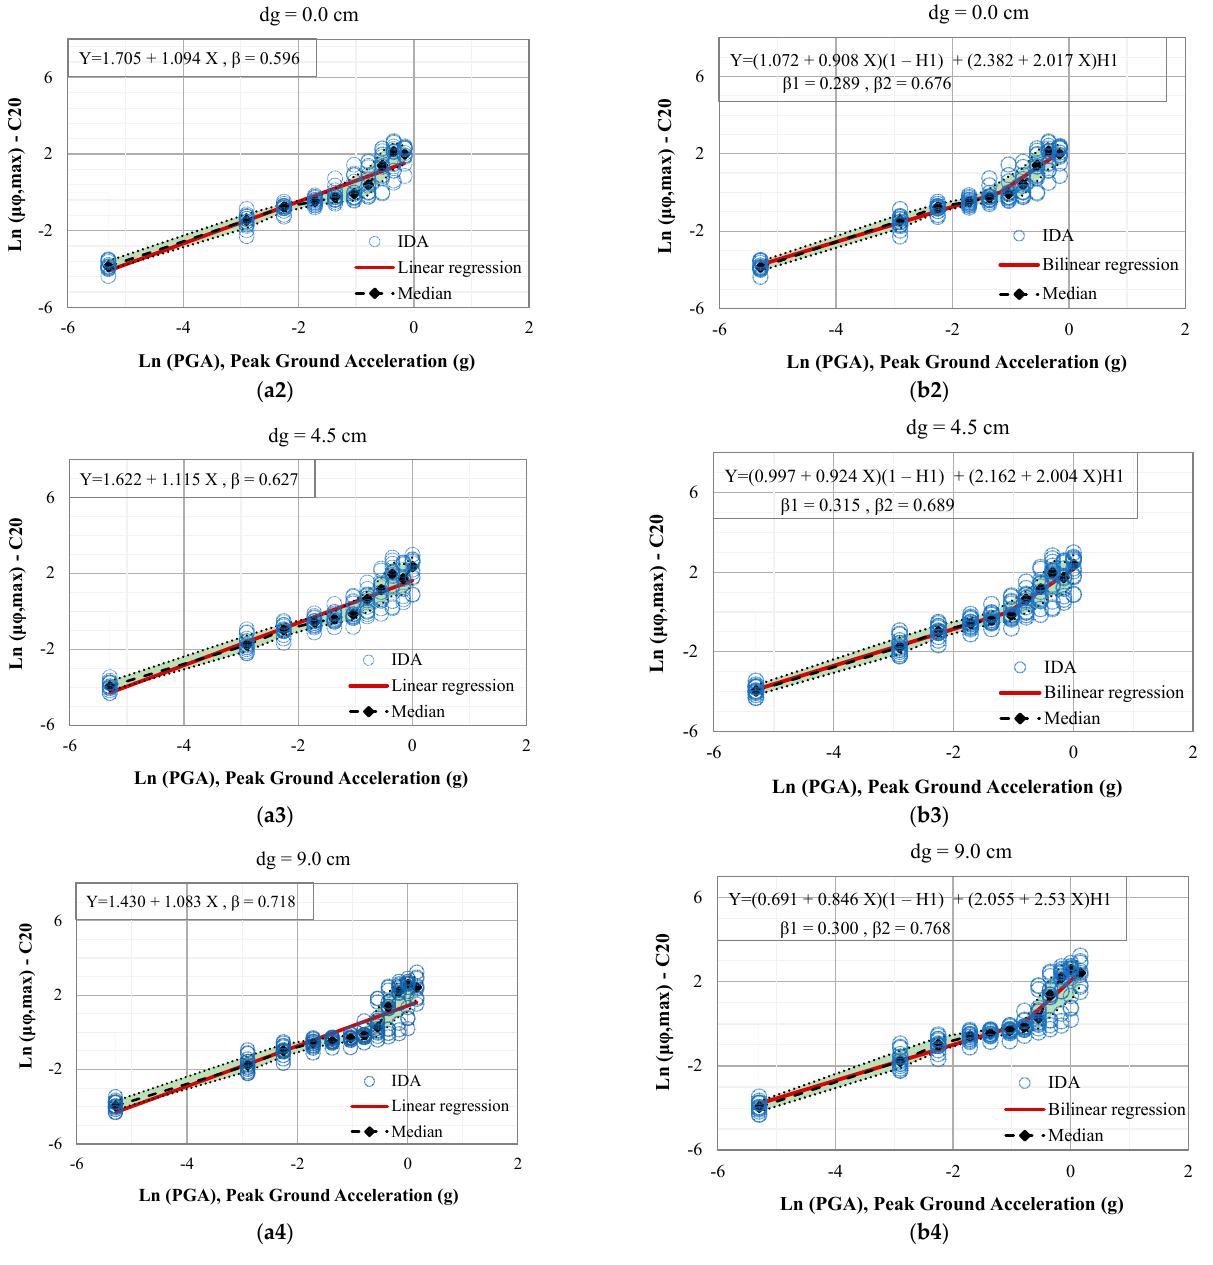
Figure 11. Comparative results in terms of μ φ ,max (column C20) at each level of PGA as deduced based on IDAs, PSDMs, and median values of demand. Regression models: ( a ) linear, and ( b ) bilinear. Examined cases: ( 1 ) without the pounding effect, ( 2 ) d g = 0.0 cm, ( 3 ) d g = 4.5 cm, and ( 4 ) d g = 9.0 cm.